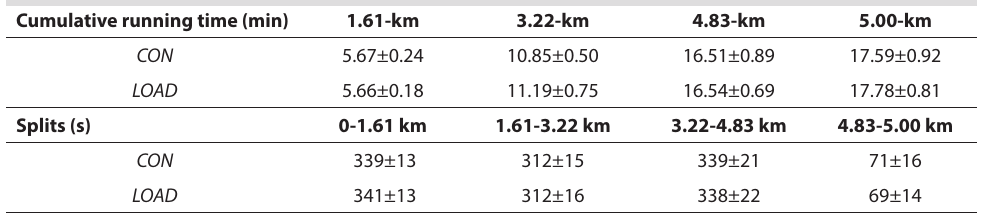
TABLE 1. Time trial performance data (n = 10; mean ± SD)